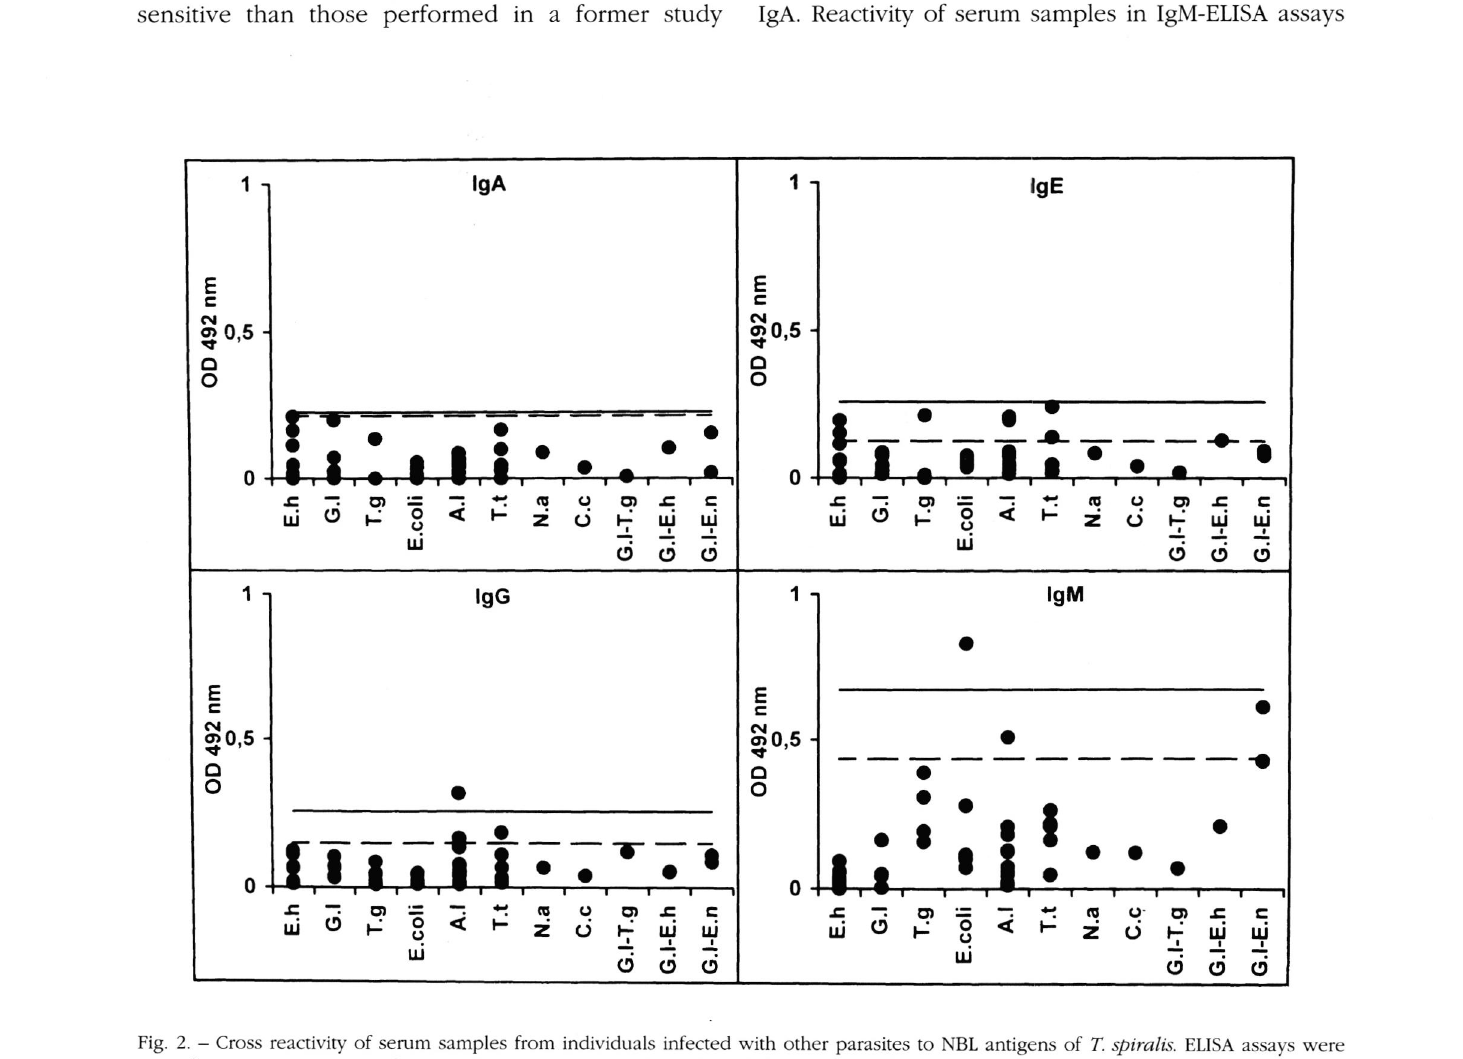
Fig. 2. - Cross reactivity of serum samples from individuals infected with other parasites to NBL antigens of T. spiralis. ELISA assays were carried out using NBL TSE of T. spiralis and serum samples collected from individuals infected with other parasites such as: Entamoeba histolytica (E.h.), Giardia lamblia (g.l.), Toxoplasma gondii (T.g.), Entamoeba coli (E.C.), Ascaris lumbricoides (A.I.), Trichuris trichiura (T.t.), Necator americanus (N.a.), Cysticercus cellulosae (C.c), Giardia lamblia and Toxoplasma gondii (G.1.-T.g.), Giardia lamblia and Entamoeba hystolitica (G.1.-E.h.) or Giardia lamblia and Endolimax nana (G.1.-E.n.) to detect cross-reactive IgA, IgE, IgG and IgM anti­ bodies. Discontinued horizontal lines indicate X ± 3 σ OD values from healthy individuals. Continued horizontal lines represents X ± 3 rj OD values of serum samples from individuals infected with other parasites. The latter was taken as the threshold value of